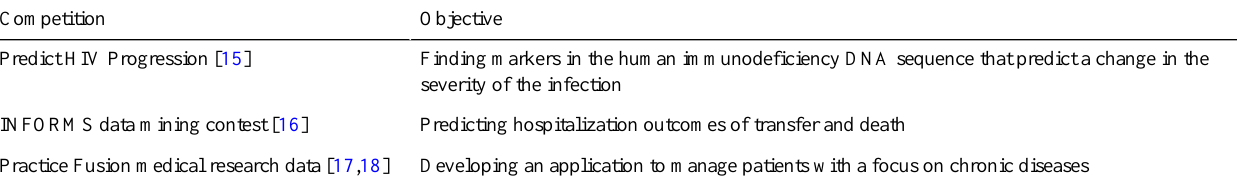
Table 1. Recent examples of public releases of health data for the purpose of